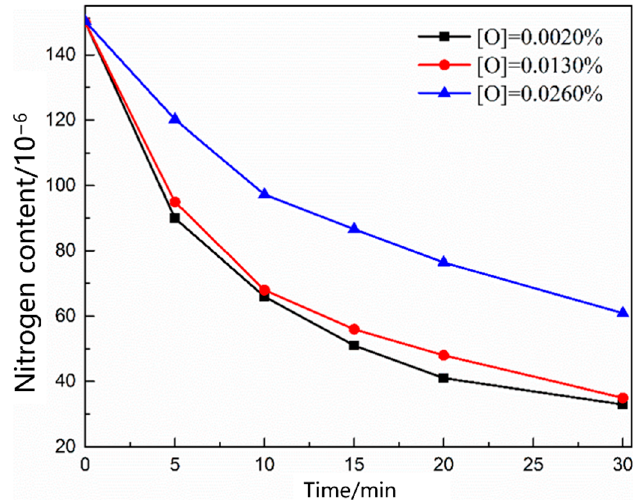
Figure 16. Change in the nitrogen content in the liquid steel with different oxygen contents.